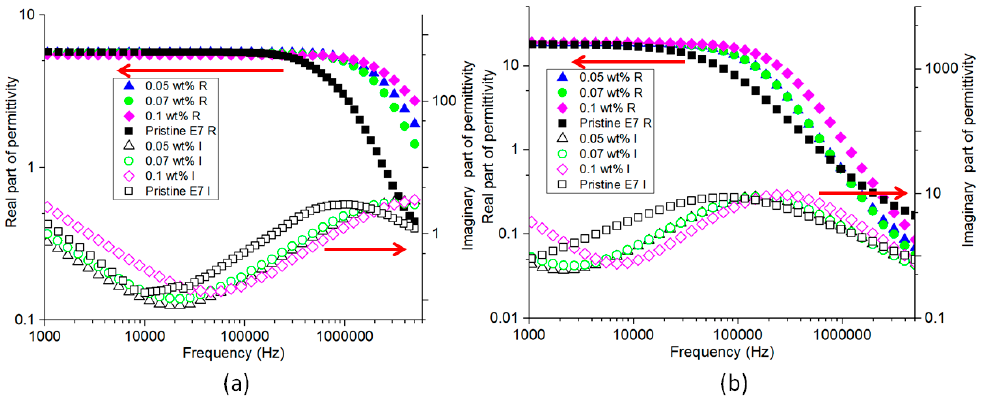
Figure 5. Dielectric spectra of ( a ) homogeneously aligned and ( b ) vertically aligned LC cells doped with various GNP concentrations. The solid and hollow symbols indicate the real part and imaginary part of permittivity, respectively.